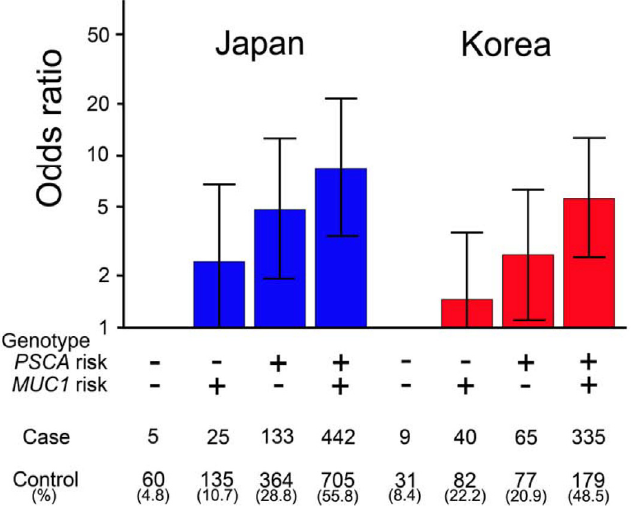
Figure 2. Japanese and Korean populations can be stratified based on PSCA and MUC1 genotypes associated with risk for DGC. The stratification and risk estimation were performed using genotype data of rs2294008 in PSCA and rs4072037 in MUC1 [9]. The risk allele’s effect is assumed to be dominant for rs2294008 in PSCA (risk genotype: TT and TC; protective genotype: CC) and recessive for rs4072037 in MUC1 (risk genotype: AA; protective genotype: GG and GA). Bar, upper and lower bounds of 95% confidence